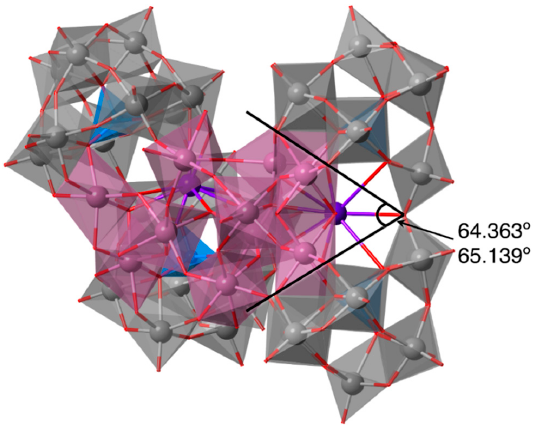
Figure 3. Bite angles of In 10 -open .